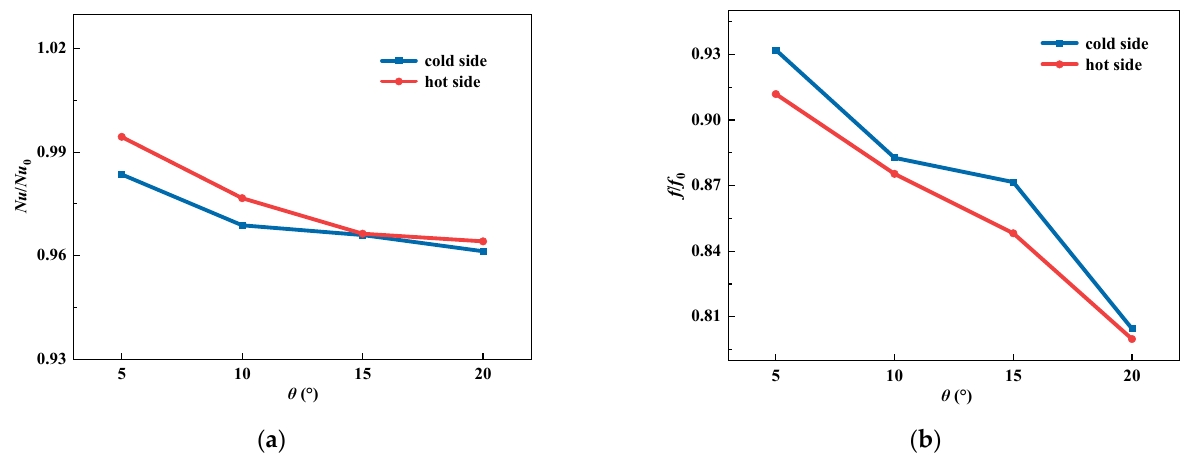
Figure 13. Effects of angle θ of spiral structure on S-ZPCHE: ( a ) Relation between Nu number and angle θ of spiral structure; ( b ) Relation between f factor and angle θ of spiral structure.